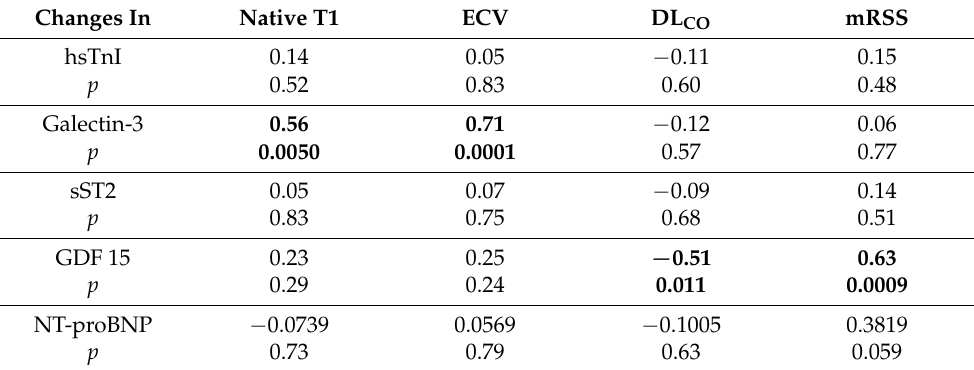
Table 2. Correlations between changes in biochemical, CMR, and activity disease